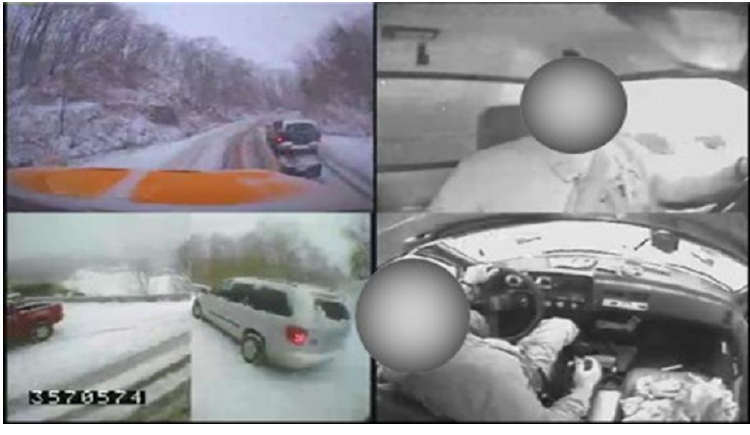
Figure 1. Five video images multiplexed into a single image.